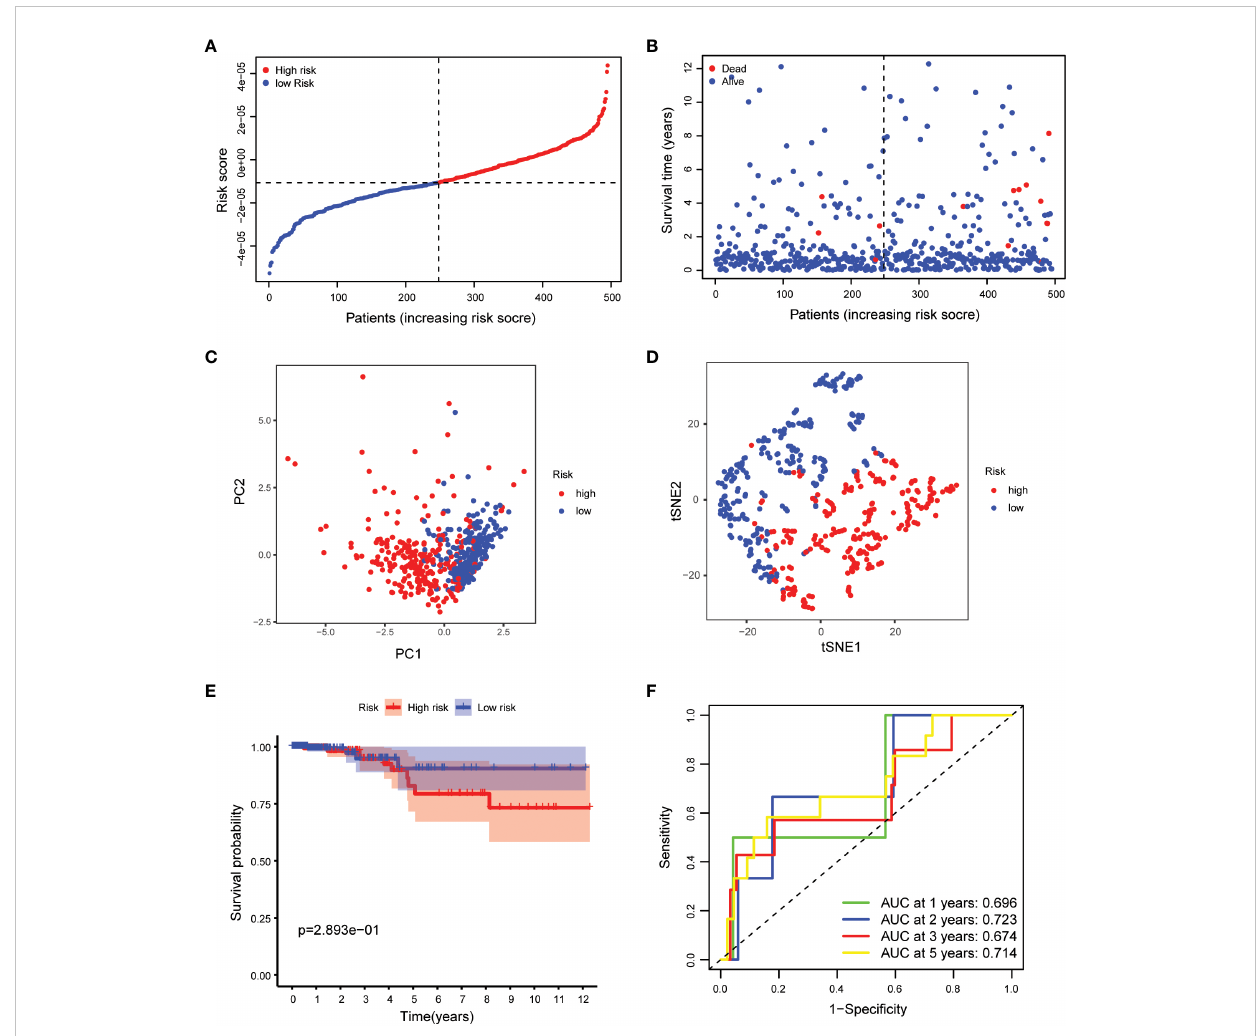
FIGURE 4 Validation of the 5-gene signature model. (A) The distribution and median value of the risk scores. (B) The distributions of OS status, OS and risk scores. (C) PCA analysis of the ICGC cohort. (D) t-SNE analysis of the ICGC cohort. (E) Kaplan-Meier curves of the OS in the two groups. (F) AUC of time-dependent ROC curves evaluated the prognostic capacity of the risk